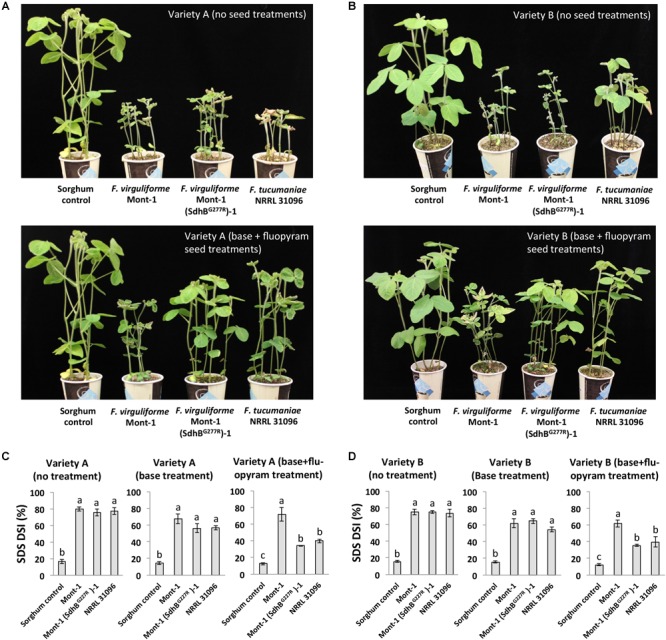
Soybean sudden death syndrome (SDS) caused by F. virguliforme strains Mont-1 and Mont-1(SdhBG277R)-1 and F. tucumaniae strains NRRL 31096 without and with fluopyram. (A) The picture of soybean SDS from variety A with no treatment and with base + fluopyram treatment infected by strains Mont-1, Mont-1(SdhBG277R)-1, NRRL 31096, and sorghum control 28 days after inoculation. (B) The picture of soybean SDS from variety B with no treatment and with base + fluopyram treatment infected by strains Mont-1, Mont-1(SdhBG277R)-1, NRRL 31096, and sorghum control 28 days after inoculation. (C) SDS disease severity index (DSI) on soybean variety A with no treatment, base treatment, and base + fluopyram treatment infected by three Fusarium strains. Means followed by the same letter are not significantly different (P < 0.05) using Fisher’s Protected Least Significant Difference test. (D) SDS disease severity index (DSI) on soybean variety B with no treatment, base treatment, and base + fluopyram treatment infected by three Fusarium strains.